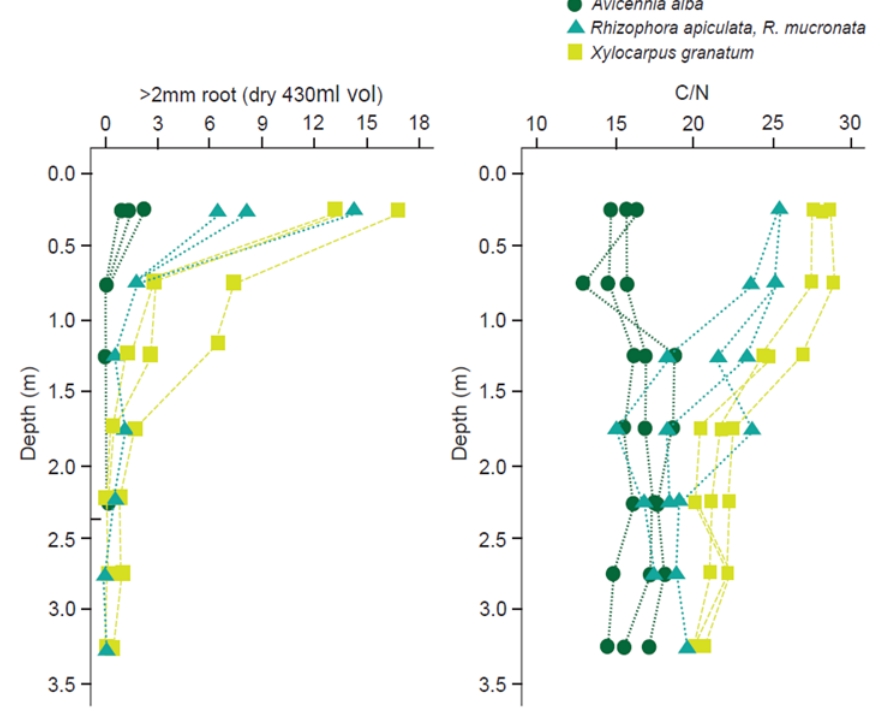
Figure 3. Vertical profiles of >2mm mangrove roots (left panel) and corresponding soil C:N in A. alba , Rhizophora spp., and X. granatum forests in the Trat River estuary, eastern Thailand to a depth of 3.5 m. Modified from Figure 2 in Kida et al. [110]. Reproduced via requirements of open access under the CC Attribution 4.0 International License (http://creativecommons.org/licenses/by/4.0, accessed 5 October 2022).